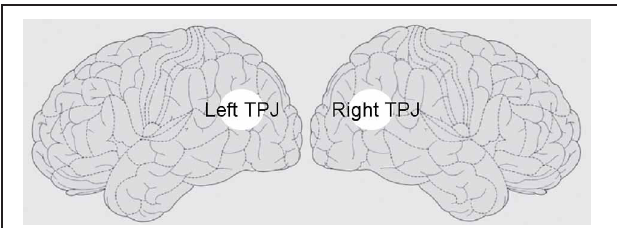
FIGURE 1 | Hypothesized neural correlates of mental bilocation. A plausible candidate for the neural substrate of mental bilocation is the point of convergence of the angular, superior temporal, and upper marginal gyri at the temporo-parietal junction (TPJ). Brain damage or brain dysfunction is localized at the TPJ in neurological patients experiencing out-of-body and he-autoscopic phenomena (Blanke et al., 2004). In healthy subjects, interference with the TPJ by transcranial magnetic stimulation impairs mental own body transformation (Blanke et al., 2005). Neuroimaging studies support the role of the TPJ in vestibular processing, integration of multisensory body related information (Leube et al., 2003), mental imagery using disembodied self location (Arzy et al., 2006), and experience of presence in virtual environments (Jäncke et al., 2009; Ganesh et al., 2012). Finally, cortex at the TPJ has also been involved in visuo-spatial perspective taking. For instance, TPJ is the classical lesion site in patients with egocentric spatial neglect, a clinical condition which has been shown to disturb the patient’s egocentric representation of space (Halligan et al., 2003). Neuroimaging studies in healthy subjects have revealed TPJ activation during visuo-spatial perspective changes (Zacks et al., 2003; Aichhorn et al., 2006; David et al.,